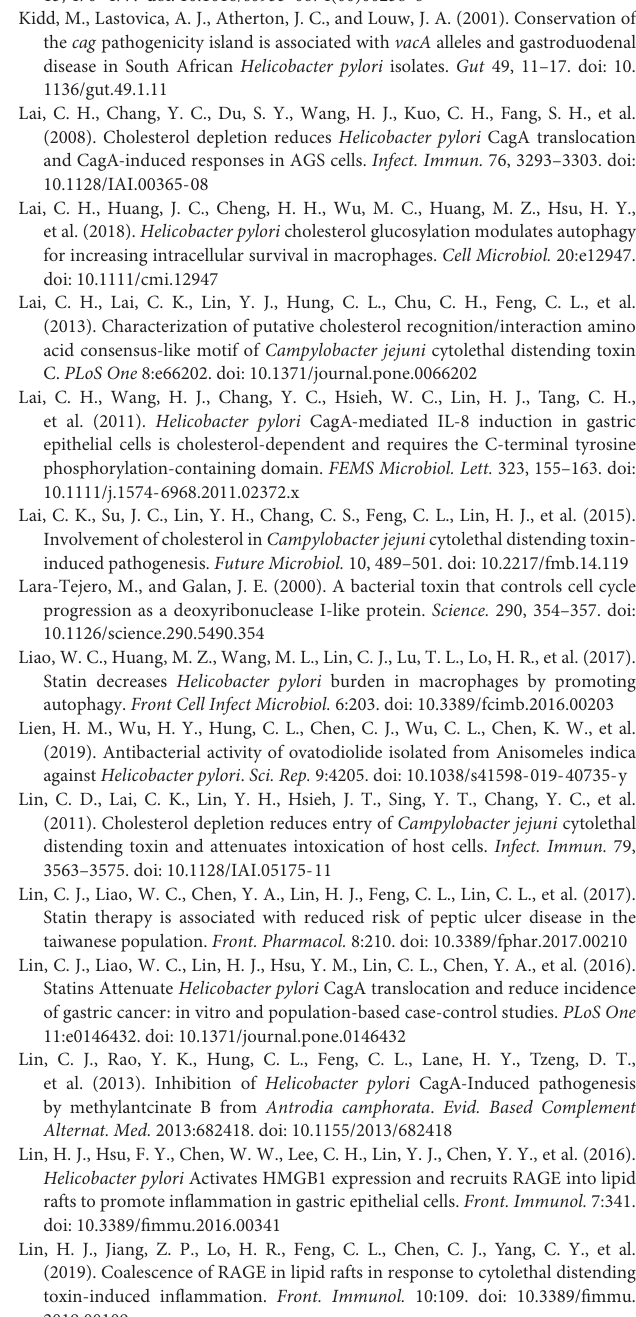
membrane is represented by the peak of wheat germ agglutinin fluorescence intensity, which is located between the two dotted lines. Supplementary Figure 4 | rCdtC decreases Helicobacter pylori invasion in gastric epithelial cells. AGS cells were untreated with rCdtC (mock), treated with 200 nM rCdtC, infected with H. pylori for 6 h, and pretreated with rCdtC then infected with H. pylori for 6 h. H. pylori (A) adhesion and (B) invasion to cells were analyzed. * P <